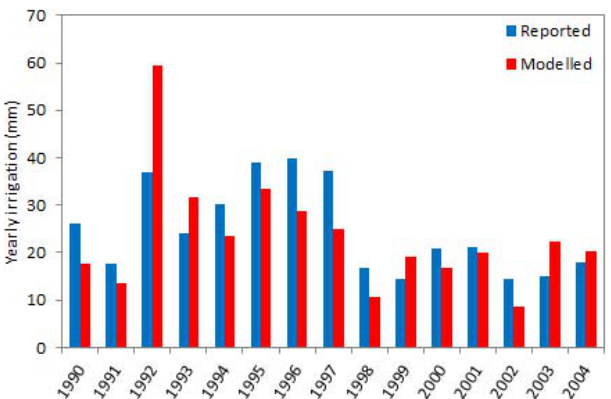
Fig. 4. Observed and simulated yearly irrigation.